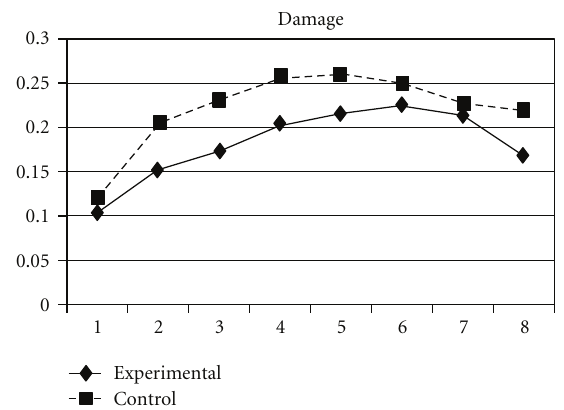
Figure 18: Growth trajectories of the experimental group (partic- ipants who perceived the program as e ff ective) and control group using the item score of damaging other’s property as the outcome